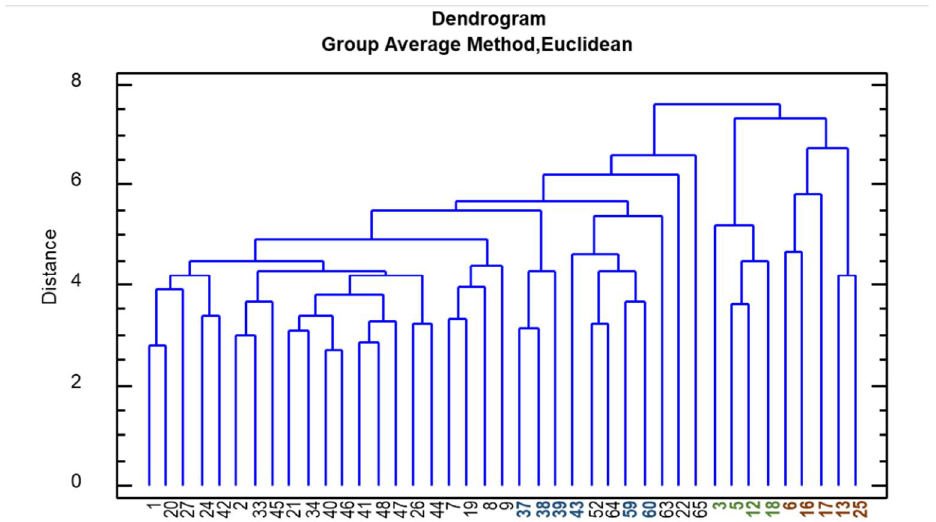
Figure 5. Hierarchical Cluster Analysis (HCA) of 41 authentic E. angustifolia accessions based on phytochemical, agronomic and morpho-quantitative characteristics.